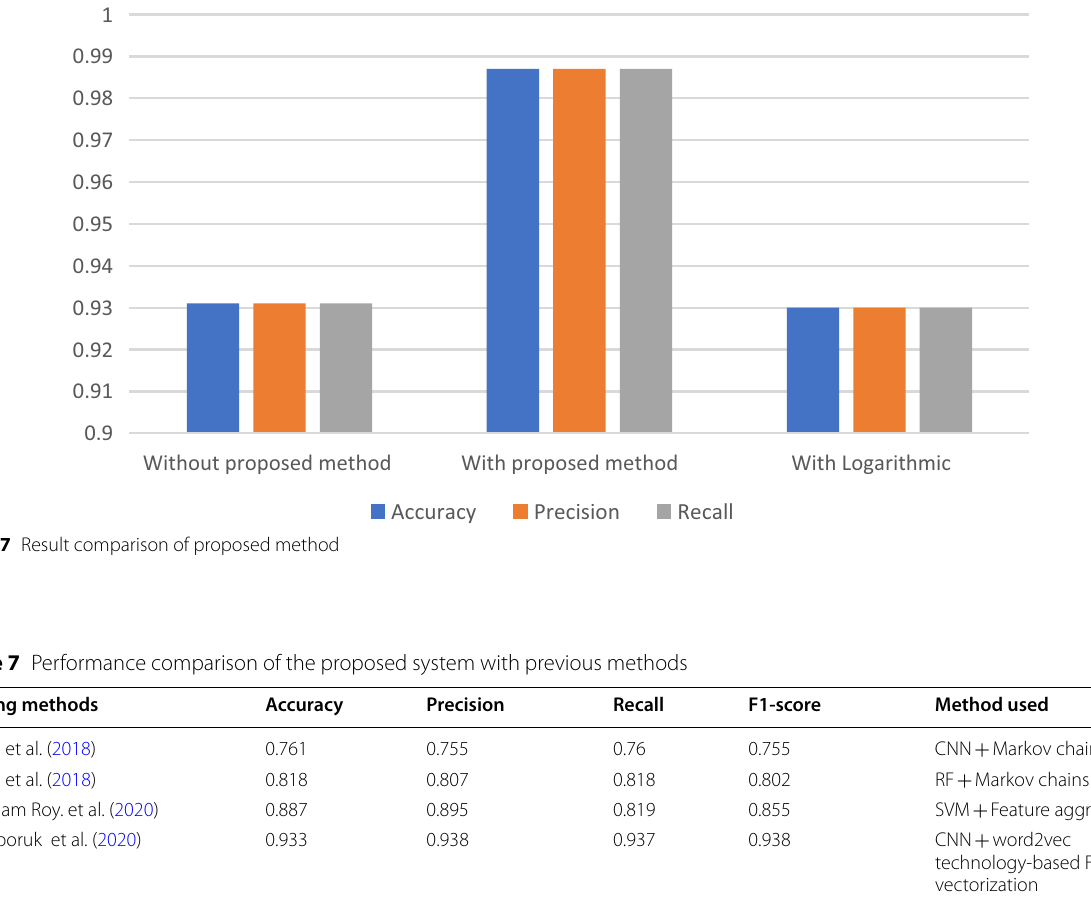
RF-Random Forest, SVM-Support Vector Machine, CNN-Convolutional Neural Networks, DNN-Deep Neural